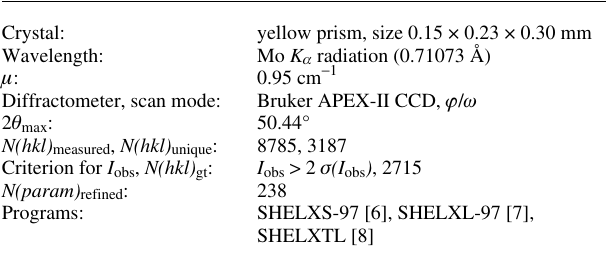
Table 1. Data collection and handling.